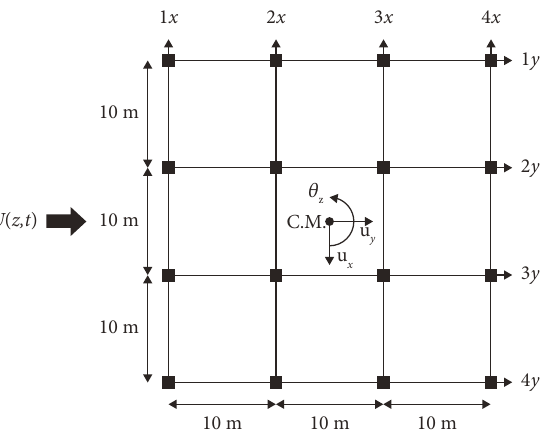
Figure 15: Lateral resisting system of the N -story shear building: 2D plan